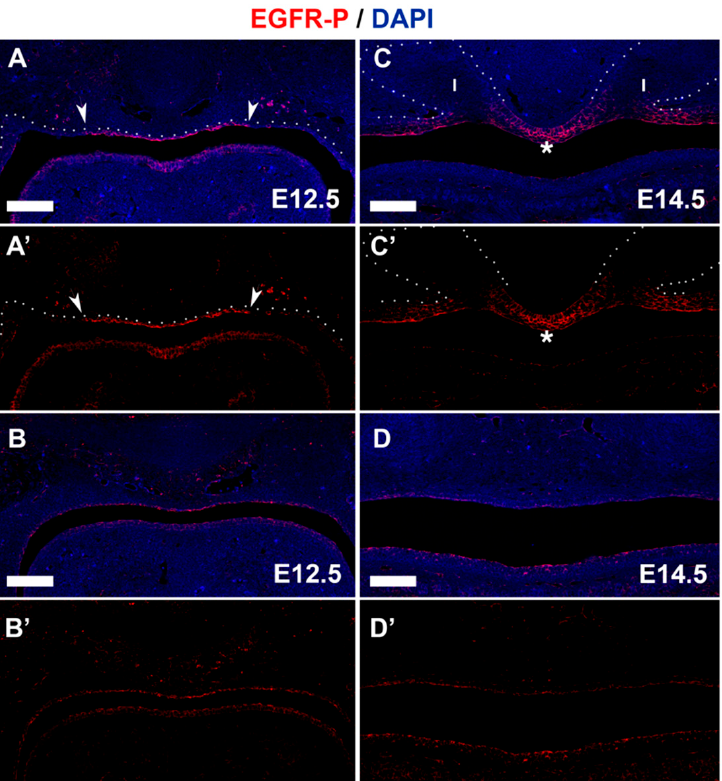
Figure 8. EGFR is expressed at high levels in the forming midline. Murine frontal sections. ( A – B’ ) E12.5. ( C – D’ ) E14.5. ( A – D ) Immunofluorescence EGFR (pink/red) plus DAPI (blue). ( A’ , B’ , C’ , D’ ) EGFR only. ( A , A’ , C , C’ ) Anterior region. ( B , B’ , D , D’ ) More posterior region. Arrows in ( A , A’ ) highlight border of expression of EGFR in the midline at E12.5. Asterix in ( C , C’ ) highlights midline between cap stage incisors (outlined with white dots). I = incisor. Scale bar in ( A , C ): 100 µ m (same scale in all images).